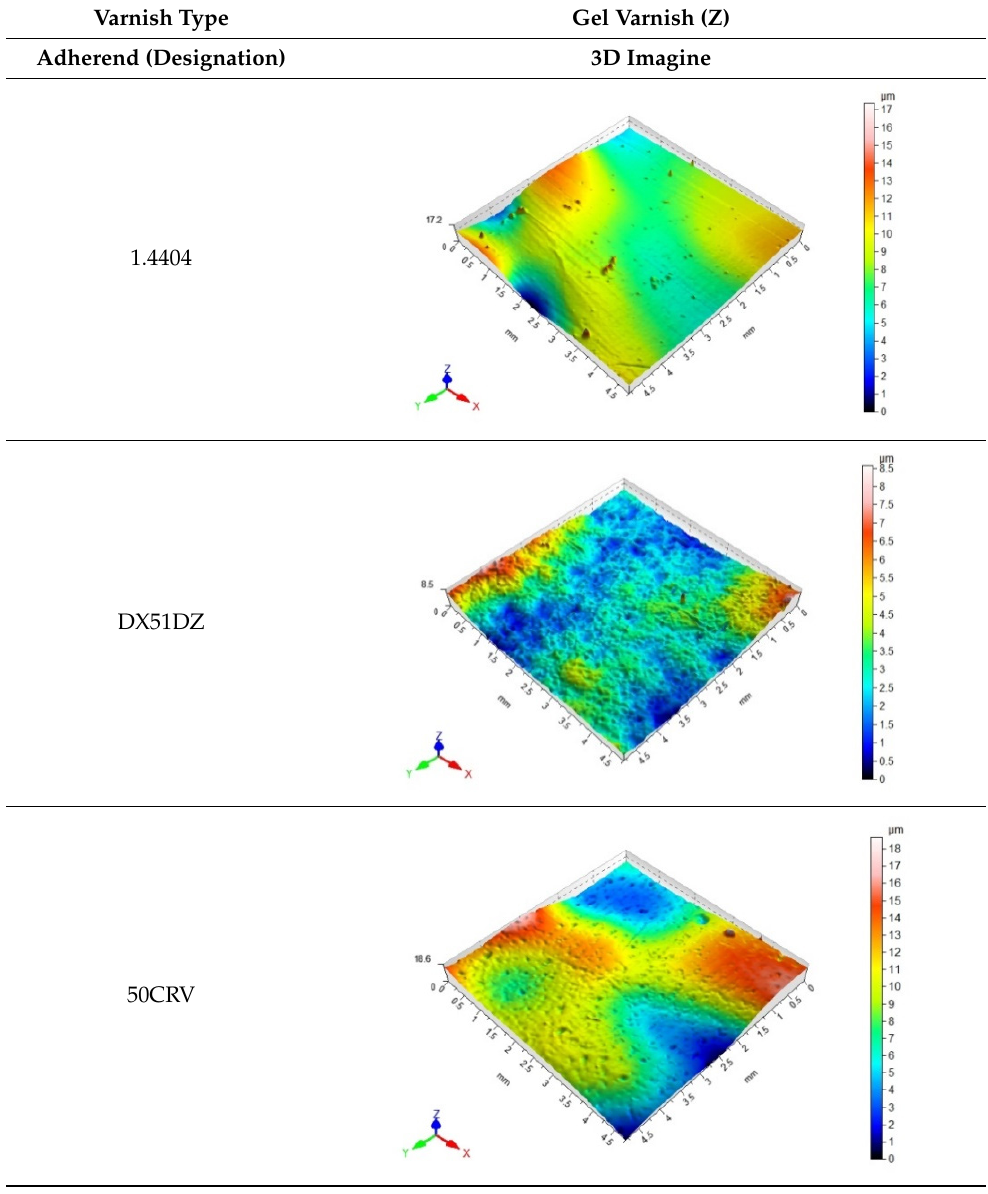
Table 13. 3D surface topography for spatial structure adherends with gel varnish (Z).